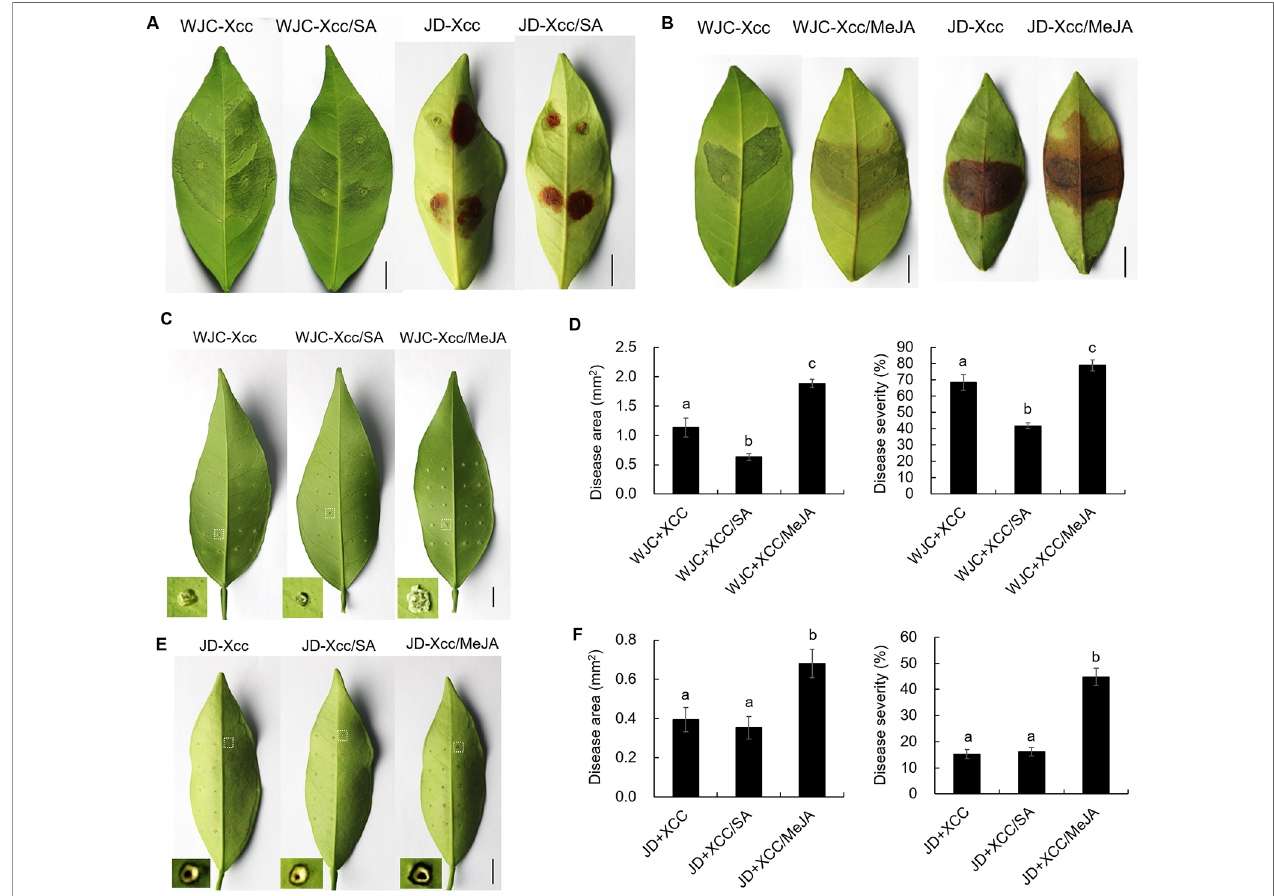
FIGURE 5 | Effects of exogenous additions of SA and MeJA on Wanjincheng orange and Jindan leaves after infection with Xcc. (A and B) Effects of exogenous SA and MeJA on Wanjincheng orange and Jindan leaves after Xcc infection by injection. The photographs were taken at 8 days after inoculation. Scale bars = 1 cm. (C) Effects of exogenous SA and MeJA on Wanjincheng orange leaves after Xcc infection by pin-prick. The photographs were taken at 8 days after inoculation. Scale bars = 1 cm. (D) Disease area and disease severity levels for Wanjincheng orange leaves after inoculation and both SA and MeJA treatments. (E) Effects of exogenous SA and MeJA on Jindan leaves after Xcc infection by pinprick. The photographs were taken at 8 days after inoculation. Scale bars = 1 cm. (F) Statistics of diseased-spot squares and disease severity levels for Jindan leaves after inoculation and both SA and MeJA treatments. Data represent the averages ± SDs from three biological repeats, and nine independent leaves were observed for each replicate experiments. Different letters above bars represent signi fi cant differences from the Xcc treatment based on Duncan ’ s multiple range test ( P < 0.05). WJC, Wanjincheng orange; JD, Jindan; Xcc, Xanthomonas citri ssp. citri ; SA, salicylic acid; MeJA, methyl